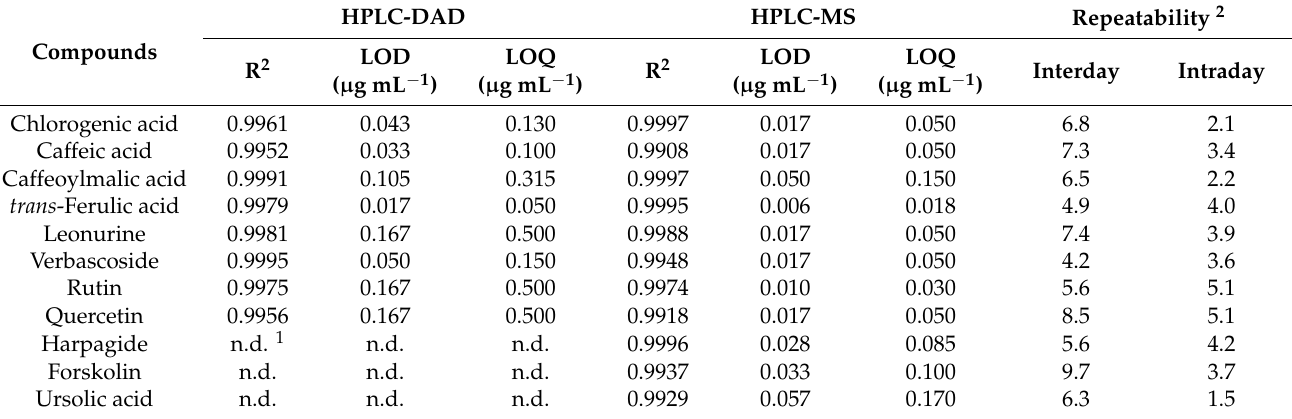
Table 1. High-Performance Liquid Chromatography coupled to Diode Array Detector and Mass Spectrometry (HPLC- DAD-MS) validation parameters, i.e., determination coefficient (R 2 ), limit of detection (LOD), limit of quantification (LOQ), and